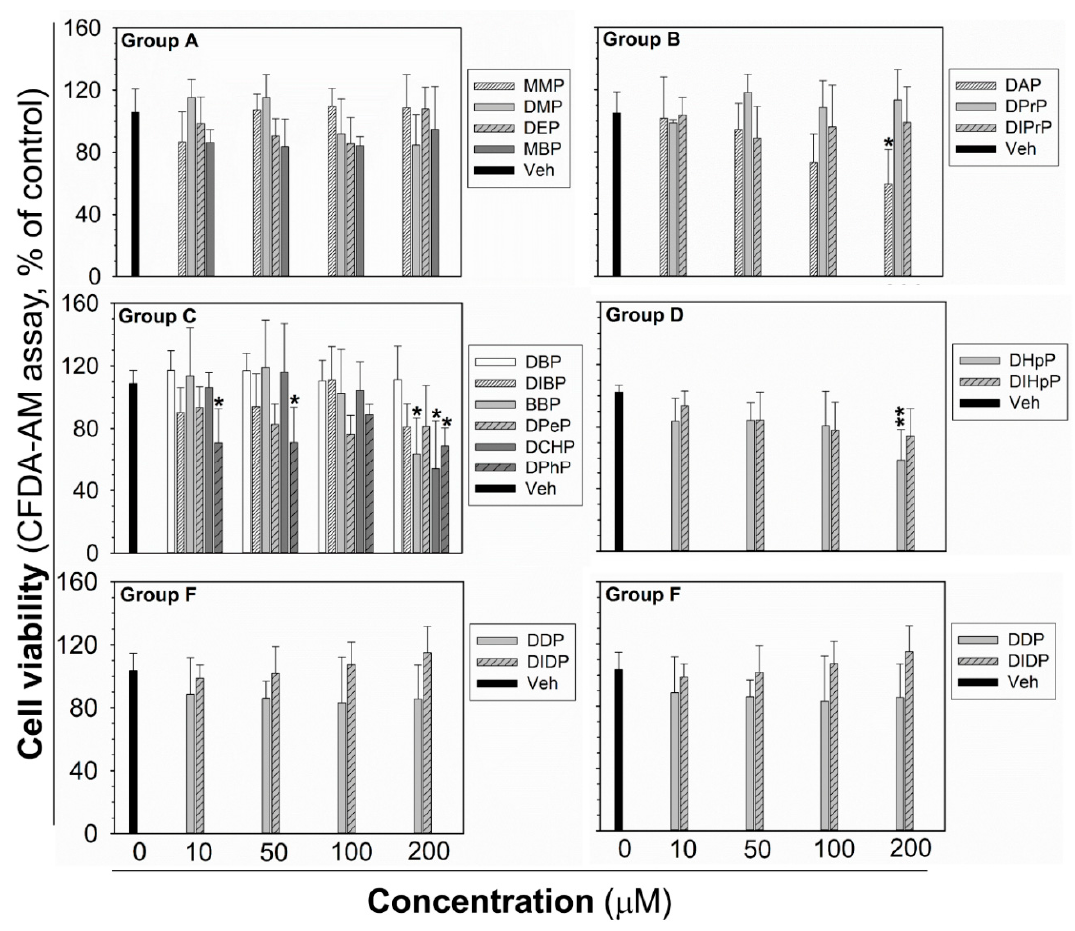
Figure 3. Cell viability of rat liver oval WB-F344 cells after 24 h treatment with phthalates evaluated